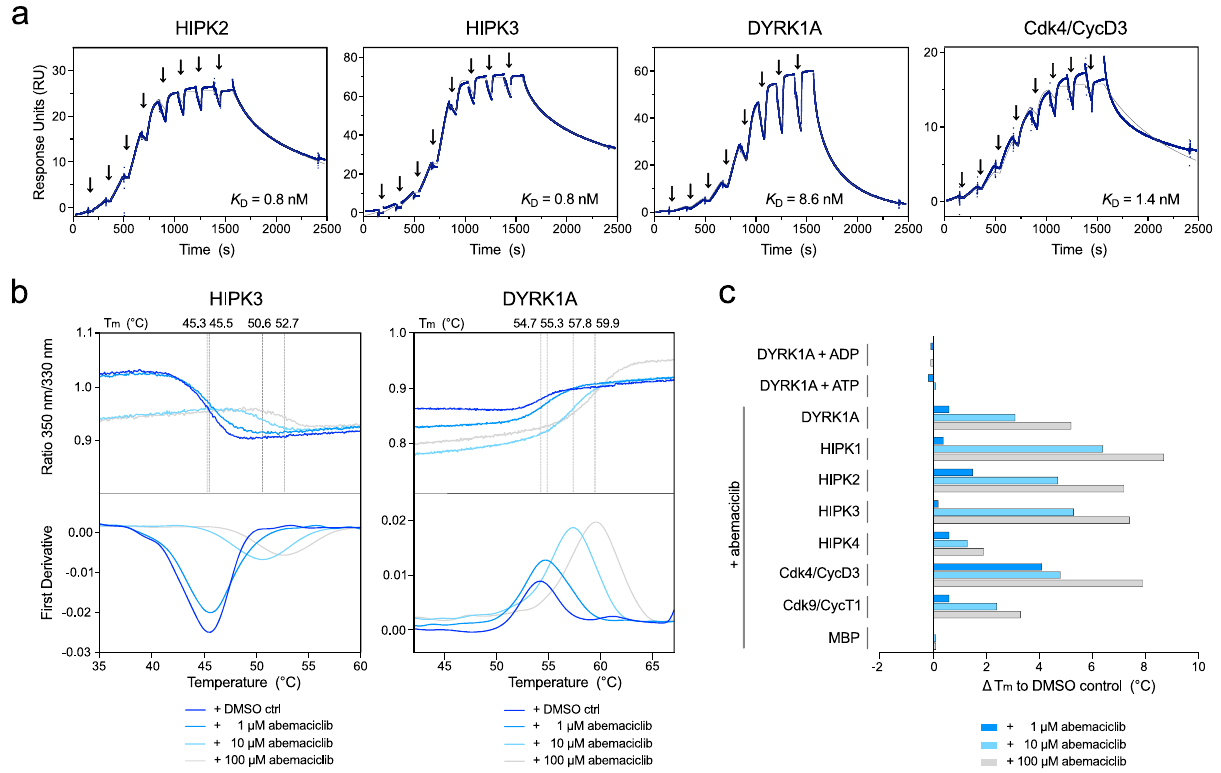
Fig. 7 Binding and af fi nity measurements of abemaciclib towards HIPK2, HIPK3, DYRK1A, and Cdk4/CycD3. a Surface plasmon resonance (SPR) measurements were performed using single-cycle kinetics. Kinases were immobilized to the chip surface by amine coupling. Abemaciclib was injected at increasing concentrations of 0.55, 1.2, 2.6, 5.8, 12.8, 28.2, 62, 136.4, and 300 nM for 120 s, followed by dissociation for 900s. Dissociation constants were determined based on fi ts applying a 1:1 interaction model. b Thermal protein stability measurements were performed using the NanoDSF technique. Proteins were diluted to 5 µ M concentration in kinase buffer and incubated with 1, 10, or 100 µ M abemaciclib for 10 min. Measurements were performed in duplicates ( n = 2 biologically independent samples) and are depicted as mean. c Thermal protein stability measurements were performed as in ( b ) using ADP·Mg 2 + , ATP·Mg 2 + , or abemaciclib. Δ T m (max. – min. in °C) is depicted as mean. For raw data see Supplementary Table 3. Source data are provided as a Source Data fi